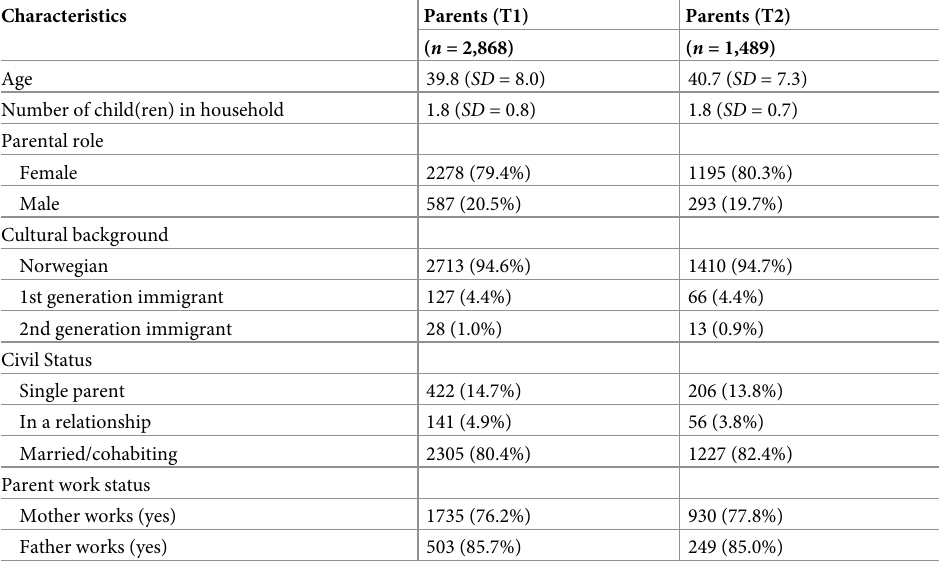
Table 1. Demographic characteristics of the study